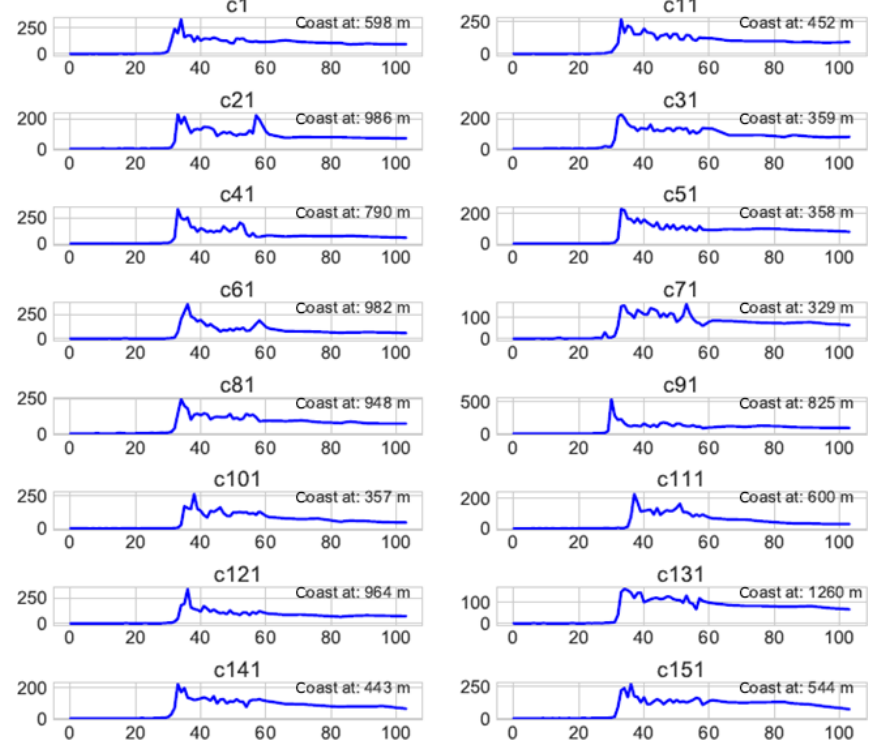
Figure 9. Observed radar waveforms at points close to the coast for a series of Jason cycles (the number on each plot refers to cycle number).